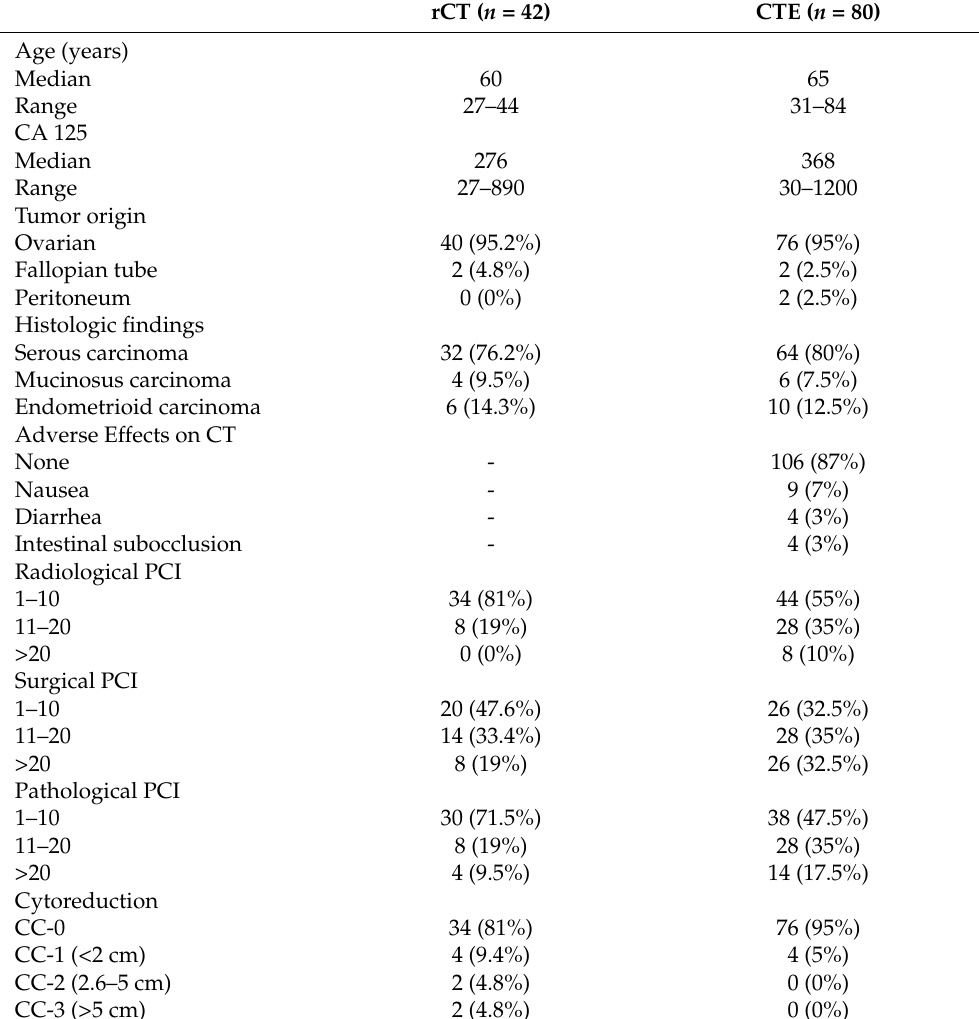
Table 1. Clinicopathologic and general characteristics of the 122 patients with advanced ovarian cancer treated by cytoreductive